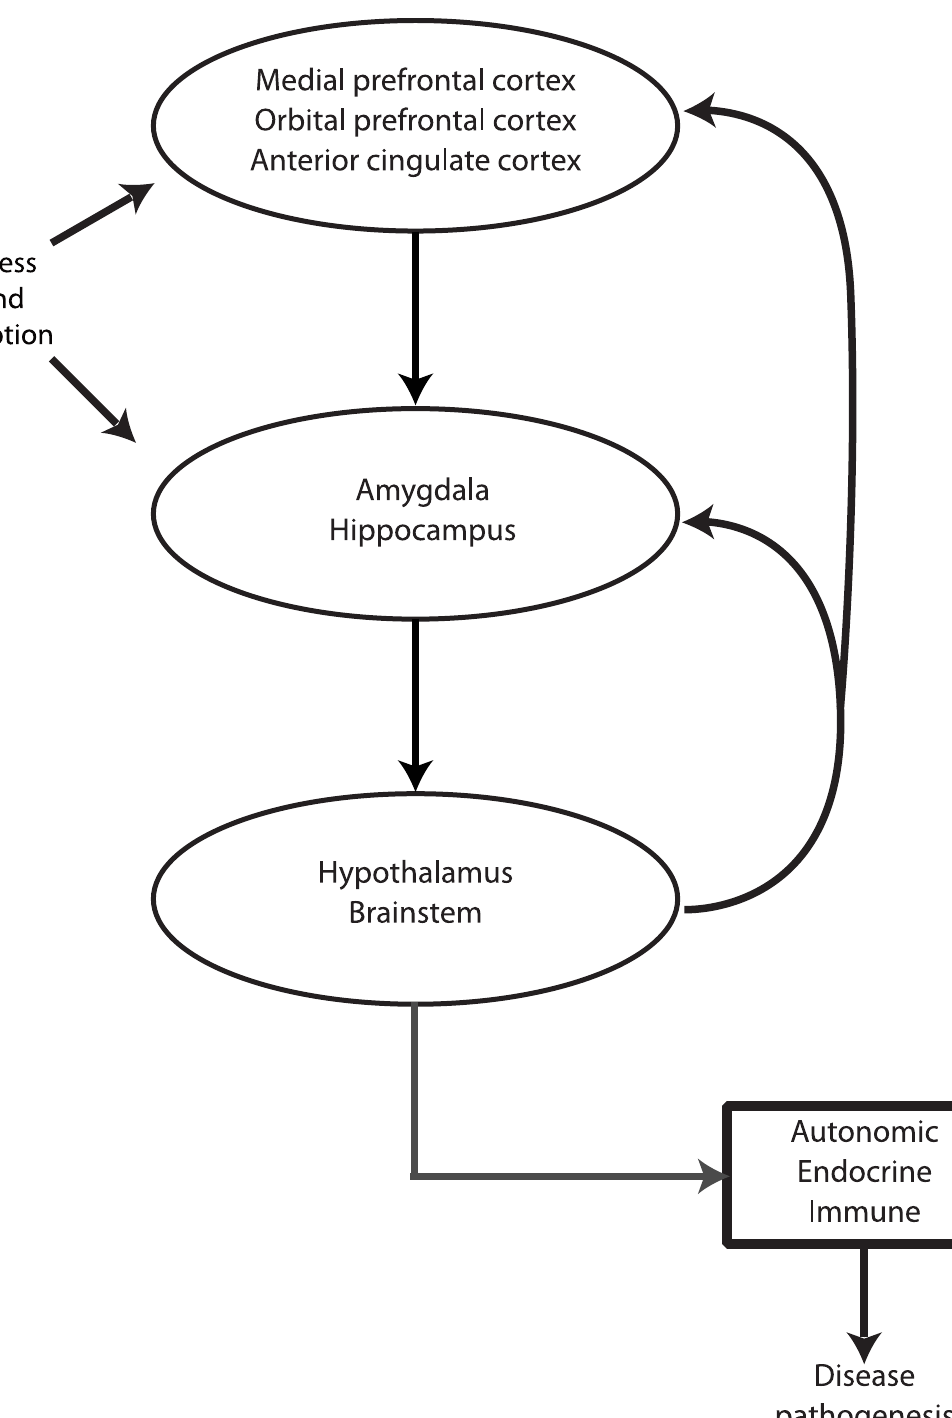
Fig 1. Simplified Heuristic of the corticolimbic circuit and its potential link to disease pathogenesis. It is posited that the translation of stress and emotion to disease outcomes involves bidirectional communication among several cortical and subcortical brain regions known to influence autonomic, endocrine, and immune system function via neural and hormonal mechanisms. Higher-order cortical regions involved in emotion regulation and stress perception, including the medial PFC, orbital PFC, and ACC, help modulate the function of subcortical regions, such as the hippocampus and amygdala, that are involved in emotion and stress processing (e.g., rapidly processing the emotional salience of an event). These subcortical regions, in turn, modulate lower-order brain